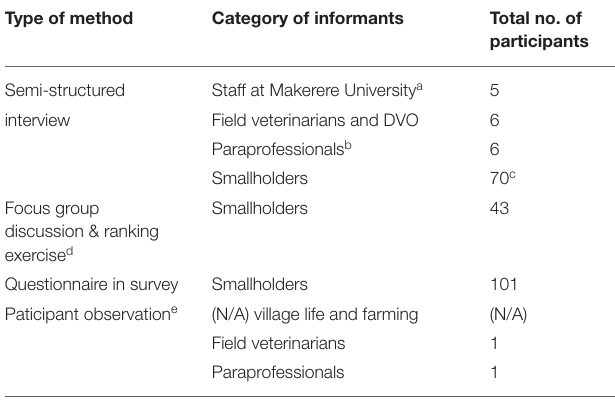
TABLE 1 | Overview of qualitative data collection: methods and